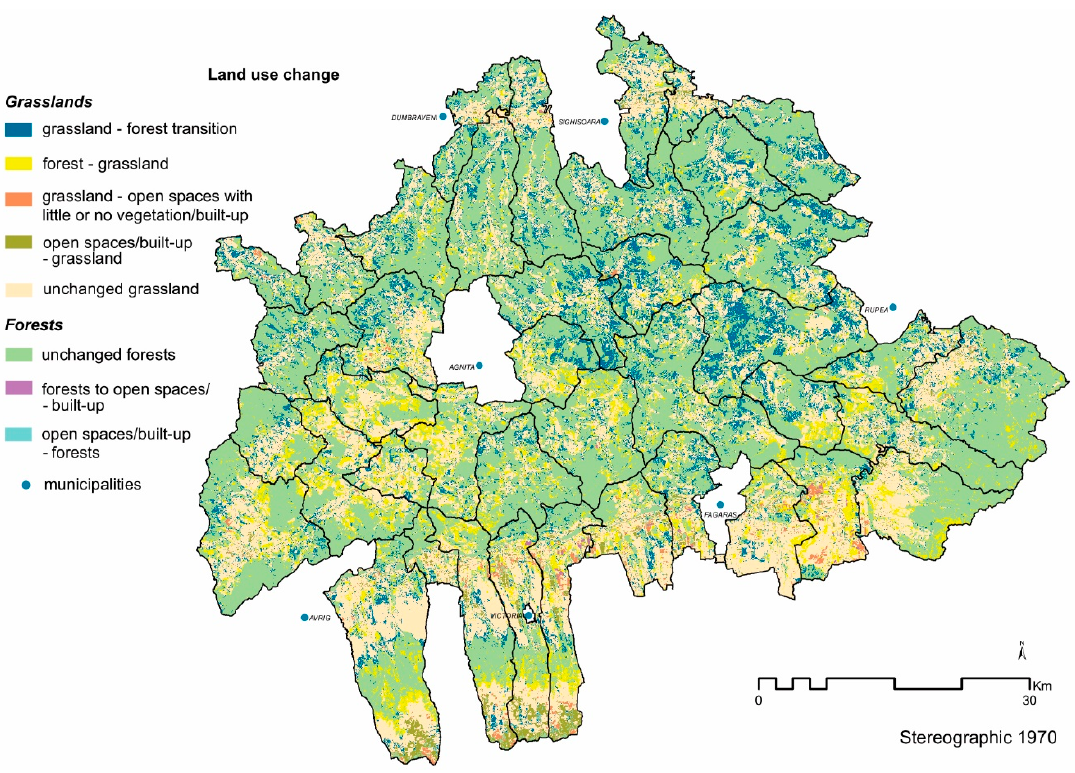
Figure 4. Land use changes during the period of 2003–2015 determined by using Landsat data .